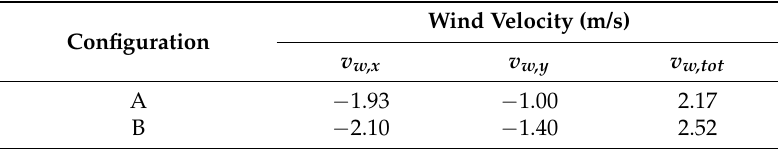
Table 4. Wind velocity expressed in the spreader coordinate system ( v w , x , v w , y ). The resulting wind velocity is given as well ( v w,tot ).